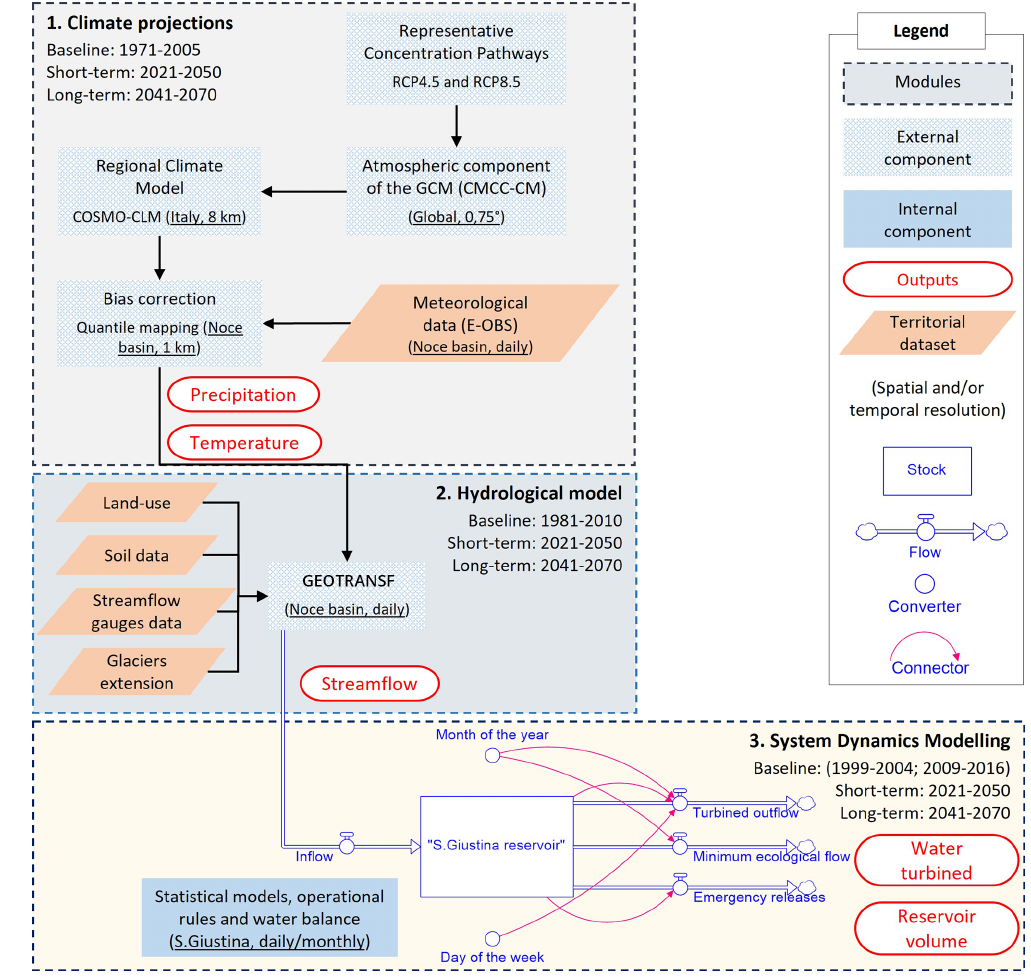
Figure 2. Models’ chain considered in this study. Box 1 includes the climate modelling used as input for the hydrological model simulation of water streamflow in box 2. Box 3 contains the SDM components of stock (S. Giustina reservoir), flows (inflow and three outflows), converters (month of the year and day of the week) and connectors (red arrows) considered to simulate stored water in the reservoir and the turbined outflow for hydropower production considering a baseline from 1999 to 2016 with a data gap from 2005 to 2008. Sources: adapted from Pham et al. (2019) and Ronco et al. (2017). For an interpretation of the references to colour in this figure legend, the reader is referred to the web version of this article. GCM: global circulation model. CMCC-CM: Centro Euro-Mediterraneo sui Cambiamenti Climatici Climate